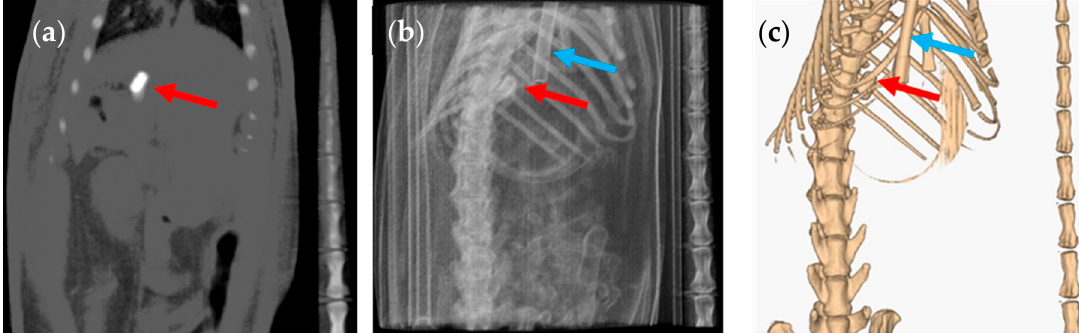
Figure 3. ( a ) Coronal CT slice of the size 9h capsule in the stomach of the rat, ( b ) planar CT projection and ( c ) three-dimensional rendered CT image of the same animal. The capsule is indicated by a red arrow and the breathing sensor by a blue arrow. Image taken under anaesthesia.